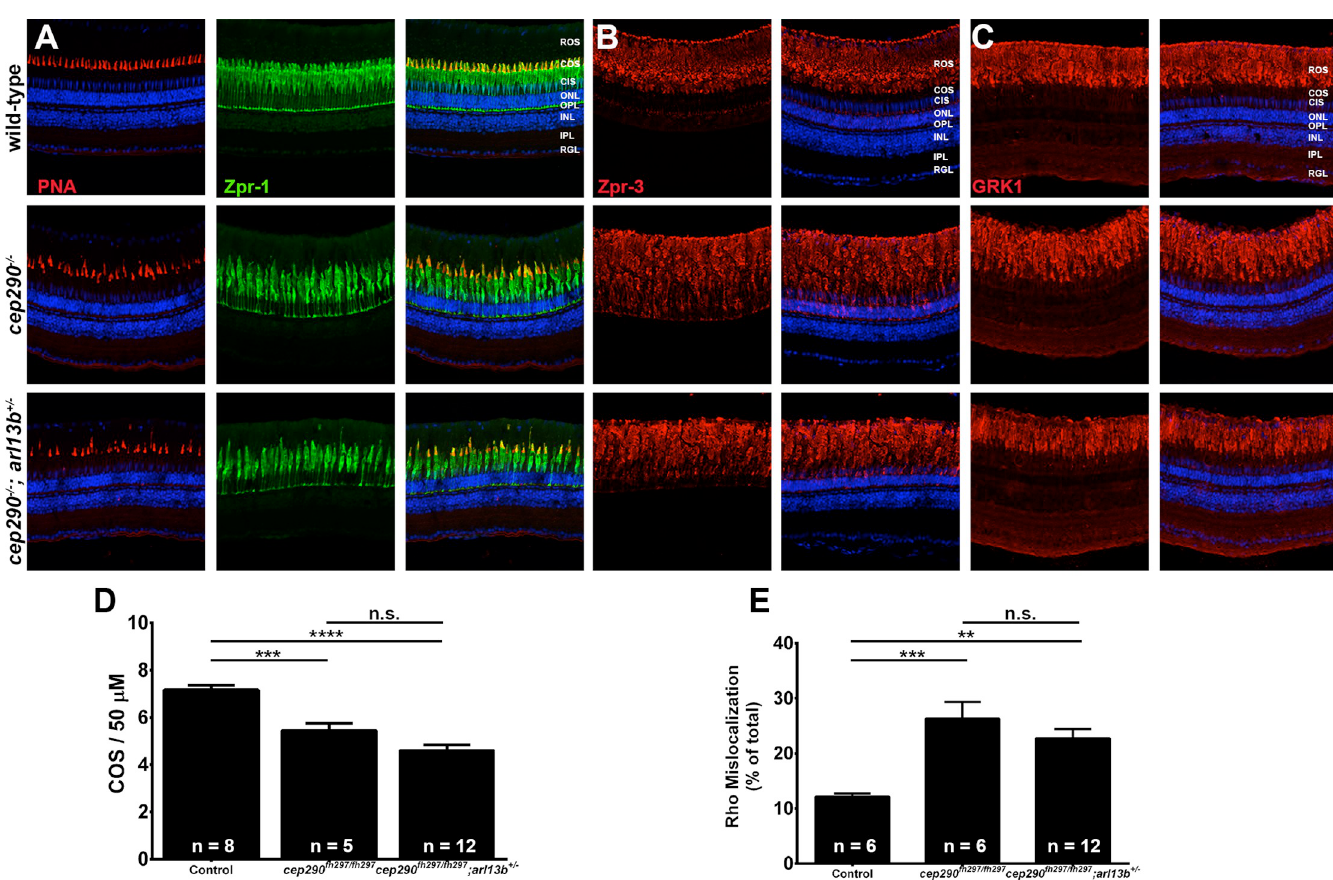
Fig 11. Combined loss of cep290 and arl13b does not exacerbate cone degeneration or rhodopsin trafficking defects. Panels show immunohistochemical analysis of dorsal retinas from wild-type (top), cep290 fh297/fh297 (middle), and cep290 fh297/fh297 ;arl13b +/- mutants (bottom) at 6 months of age stained with (A) PNA (red) and Zpr-1 (green) to label cone photoreceptor; (B) Zpr-3 to label rhodopsin; or (C) GRK1 to label rhodopsin kinase. ROS, rod outer segments; COS, cone outer segments; ONL, outer nuclear layer; OPL, outer plexiform layer; INL, inner nuclear layer; IPL, inner plexiform layer; RGC, retinal ganglion cells. Scale bar: 50 μ m. (D) Quantification of cone outer segment density or (E) rhodopsin mislocalization from the indicated genotypes at 6 months of age. See methods section for details on quantification. Removing one allele of arl13b from a cep290 fh297/fh297 mutant background had no effect on cone degeneration or rhodopsin mislocalization. At least 5 unique fish over at least 2 independent experiments were evaluated. �� P < 0.001; ��� P < 0.0005; ���� P < 0.0001 as determined by a 1-way ANOVA with a Multiple Comparisons test and Tukey corrections. Data represented as means ± s.e.m.